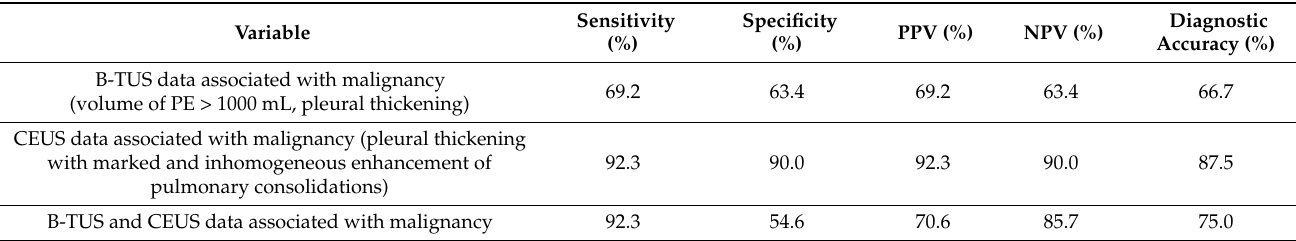
Table 5. Diagnostic performance of B-TUS and CEUS for evaluating PE malignancy in a subgroup of n = 24 patients with initial negative cytology and clinical suspicion of malignant PE.